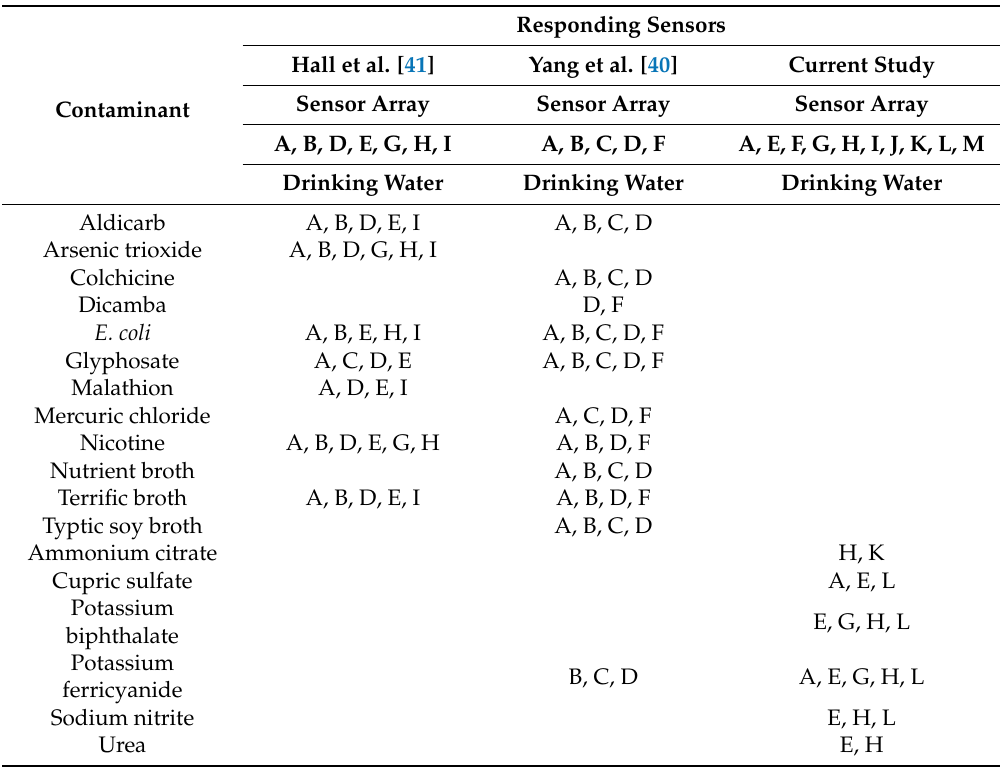
Table 2. The responding sensors to various